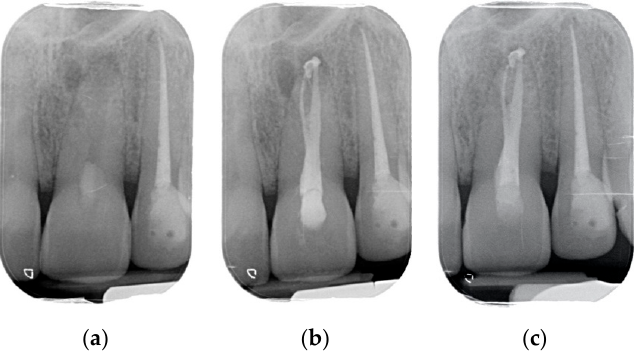
Figure 1. ( a ) Upper central incisor with periapical lesion. ( b ) The root after being endodontically treated. A second root was filled by warm gutta-percha technique. A direct resin composite restoration was used to restore the coronal part of the tooth. ( c ) The root after 3 years of clinical service. A complete healing is evident.